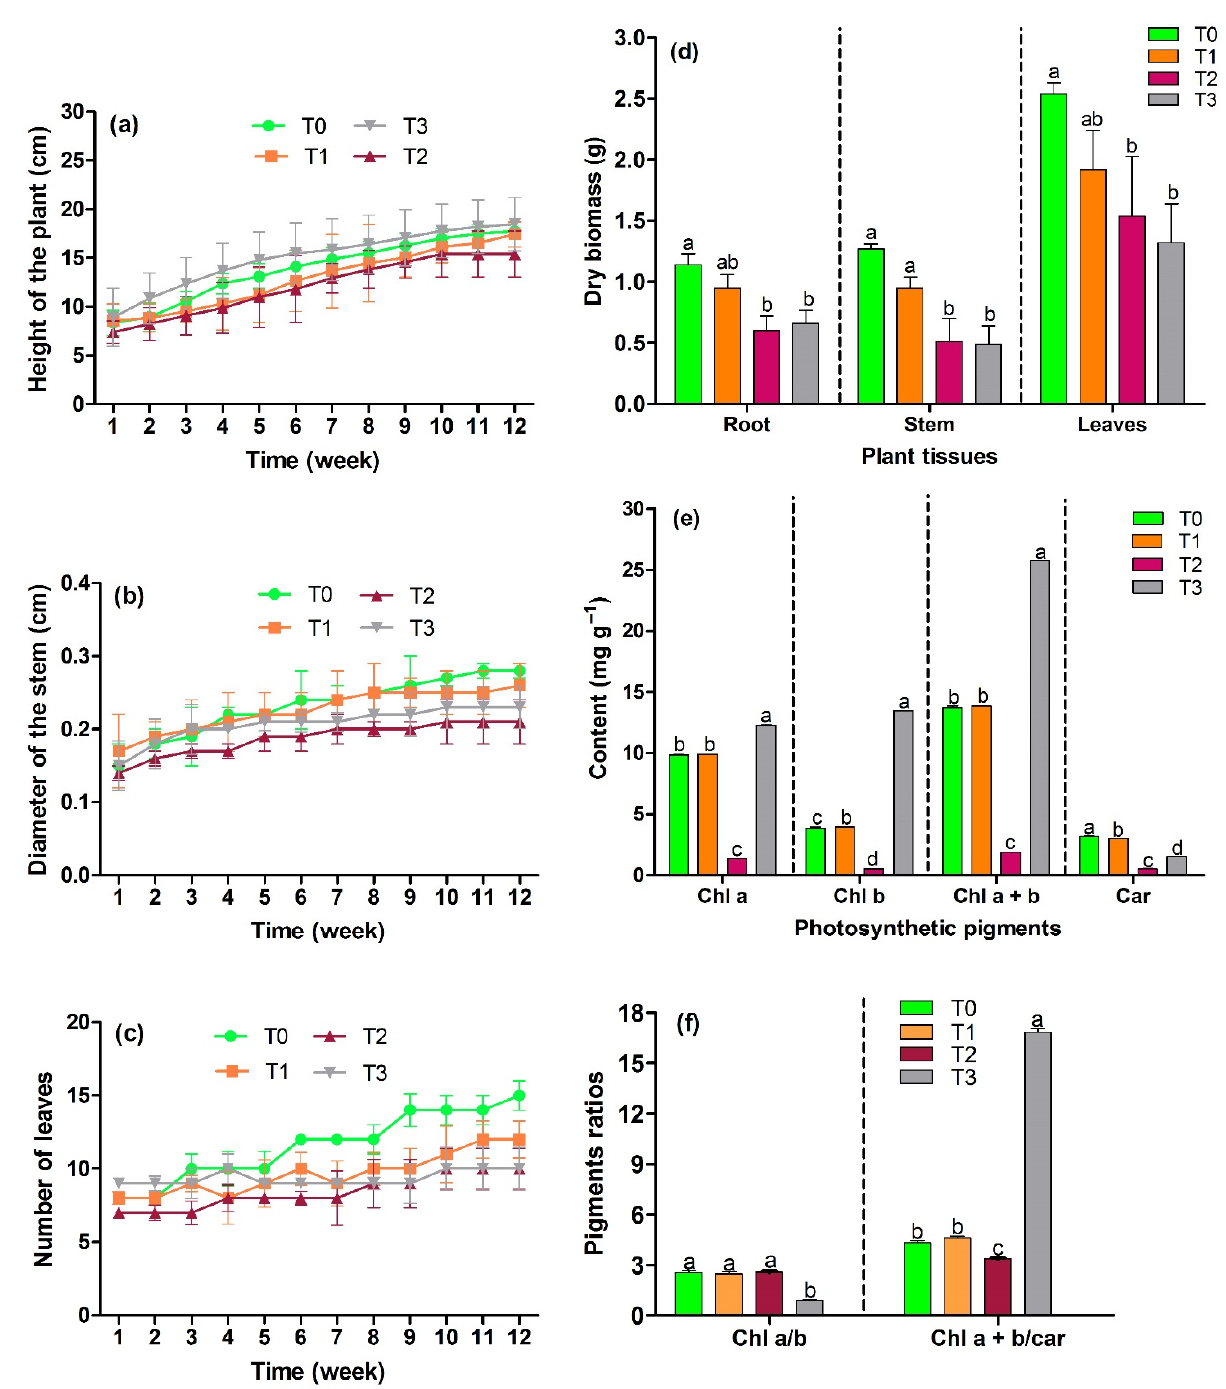
Figure 1. Behavior of morphometric parameters, growth, and dry biomass of C. sericea . ( a ) Height of the plant. ( b ) Diameter of the stem. ( c ) Number of leaves. ( d ) Dry biomass per tissue for each treatment, total biomass is the sum of tissues per treatment. ( e ) Photosynthetic pigments. Chlorophyll a. Chlorophyll b. Chlorophyll a + b. Carotenoids. ( f ) Pigments ratios. Chlorophyll a/b. Chlorophyll a + b/carotenoids. Different letters indicate significant statistical differences ( p < 0.05) using Tukey’s test between each treatment per variable.